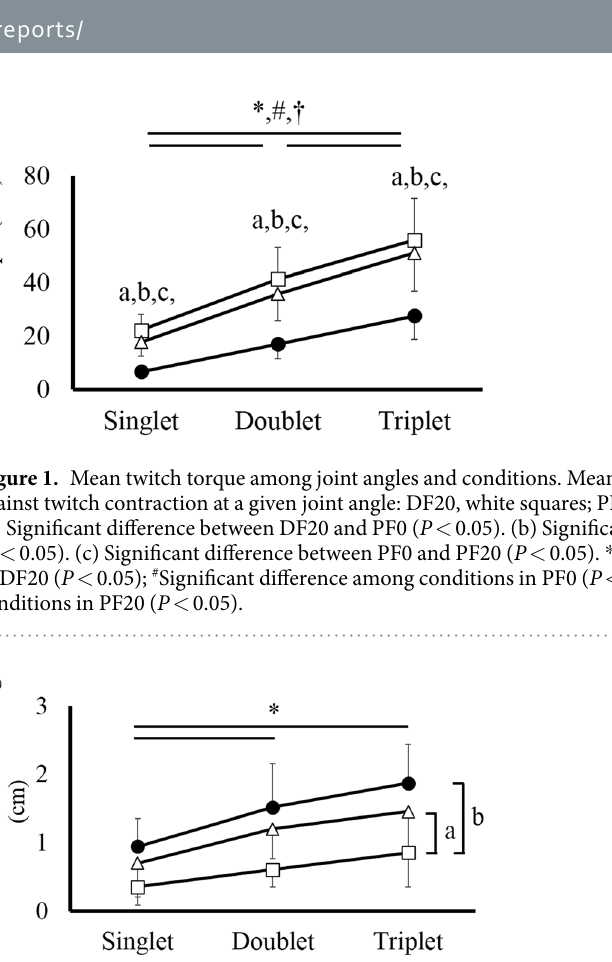
Figure 2. Fascicle shortening among joint angles and conditions. Mean fascicle length ± SD measured at each twitch contraction condition: DF20, white squares; PF0, white triangles; PF20, black circles. (a) Significant difference between DF20 and PF0 ( P < 0.05). (b) Significant difference between DF20 and PF20 ( P < 0.05). * Significant difference among conditions ( P <